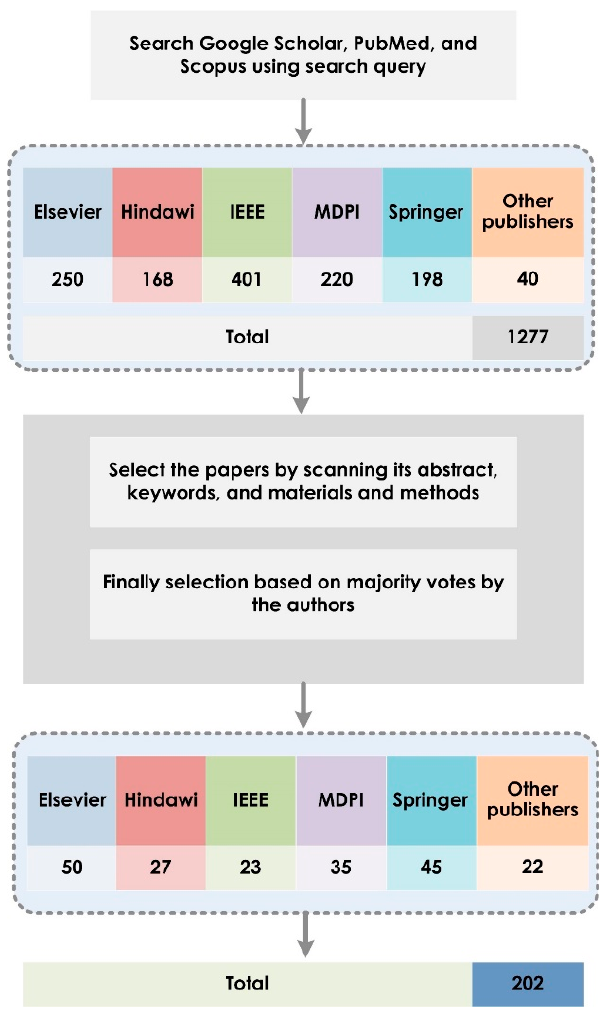
Figure 2. Overview of the selection process for relevant articles.